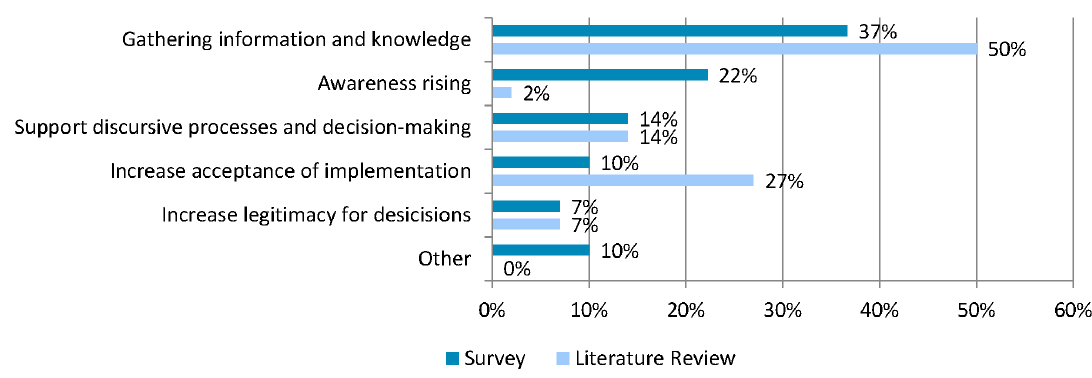
Figure 2: Reasons for stakeholder involvement (Survey: 90 answers, multiple answers allowed; Review: 44 mentions)